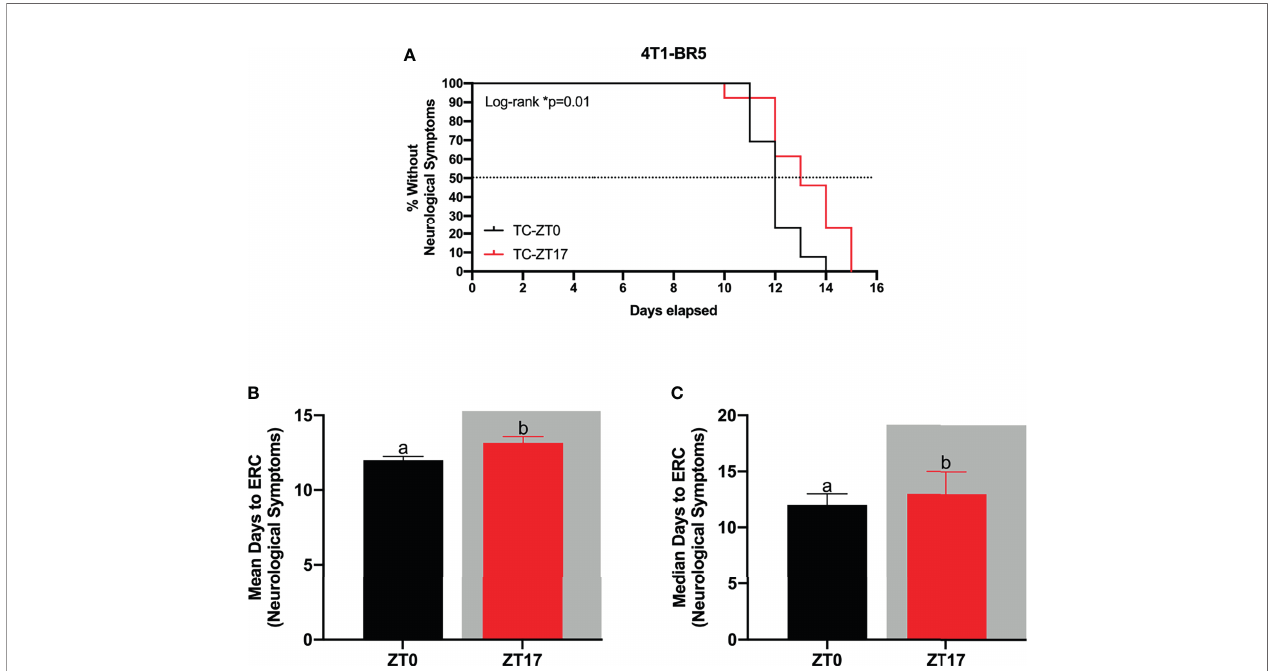
FIGURE 3 | Optimal timing of chemotherapy delays onset of neurological symptoms in 4T1-BR5 murine model of BMBC. (A) Administration of paclitaxel at ZT17 (i.e., TC-ZT17, n=13) prolonged the onset of neurological symptoms relative to mice harboring BMBC and receiving paclitaxel injections at ZT0 (i.e., TC-ZT0, n=13). Additionally, mice harboring BMBC and receiving paclitaxel injections at ZT17 demonstrated signi fi cantly prolonged (B) mean and (C) median number of days until the onset of neurological symptoms relative to ZT0. The data are presented as mean +SEM for (B) and median +95% CI for (C) . Graph bars that do not share a letter are statistically signi fi cantly different at p<0.05. * Log-rank p<0.05. (A) Log-rank test (B) unpaired t -test (C) Mann Whitney